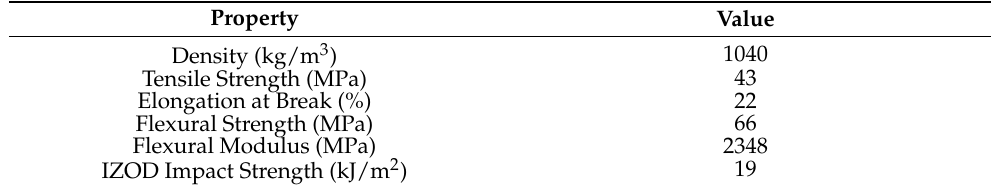
Table 6. Material properties of filament.